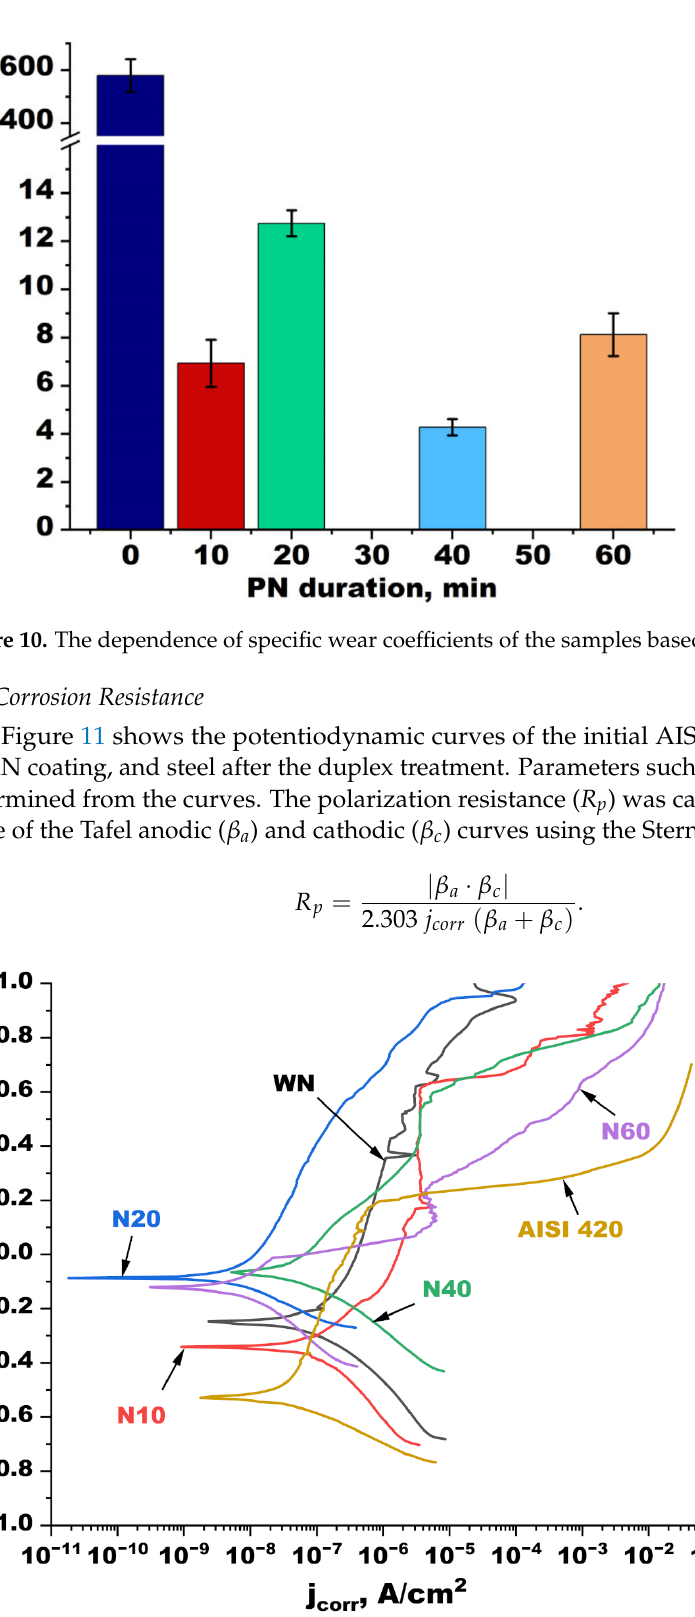
Figure 11. Potentiodynamic curves of initial AISI 420 steel substrates, with CrAlN coating (WN) and after the duplex treatment, depending on PN duration: N10 (10 min), N20 (20 min), N40 (40 min), and N60 (60